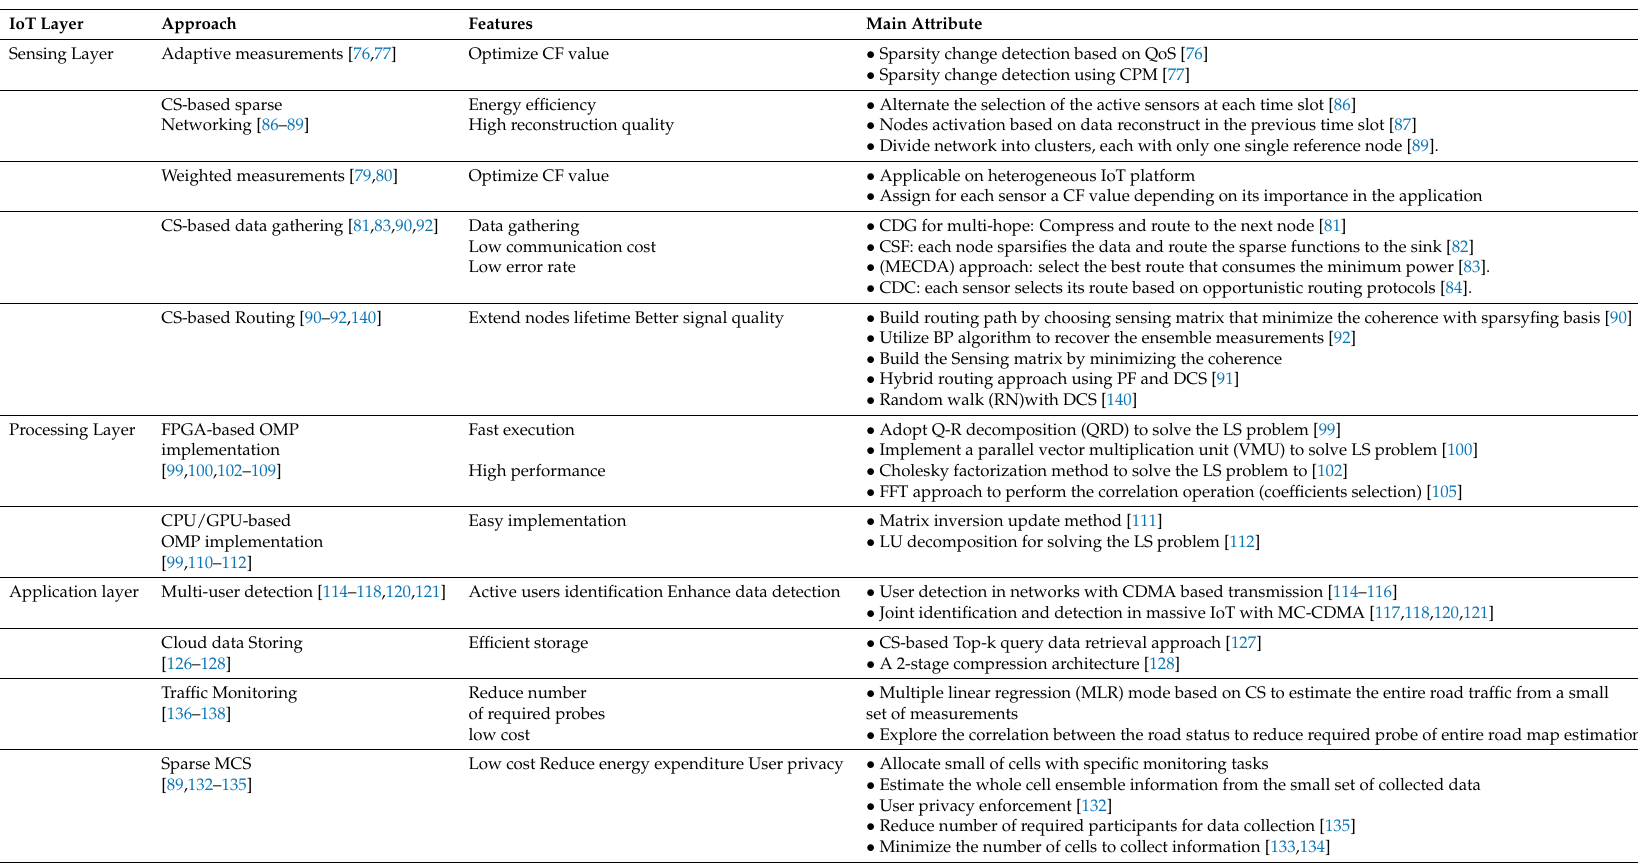
Table 4. Summary of the Joint CS-Based approaches for IoT